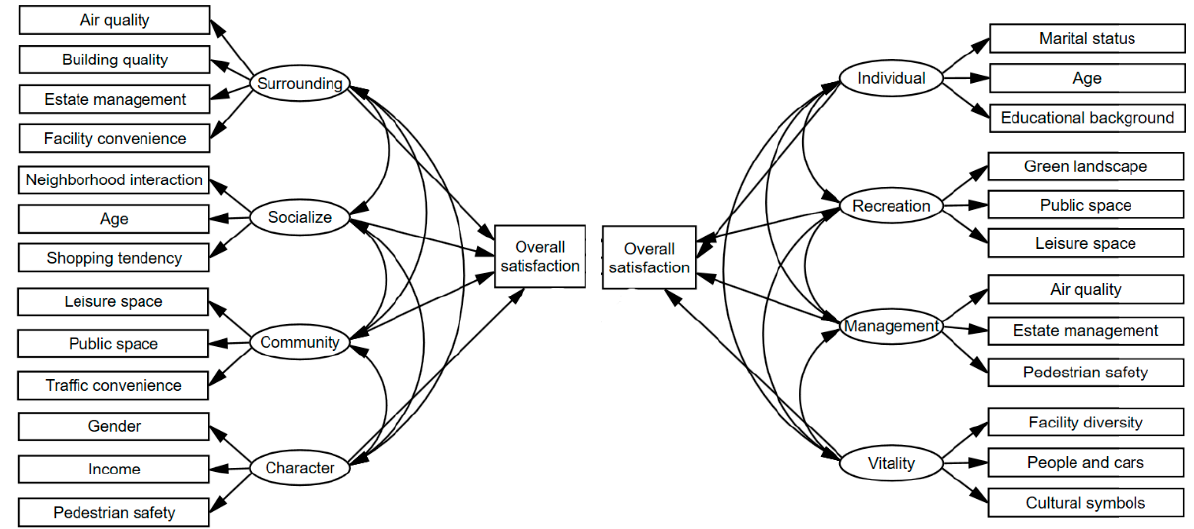
Figure 8. Model structure ( left : Nanhuan; right : Daoqian).